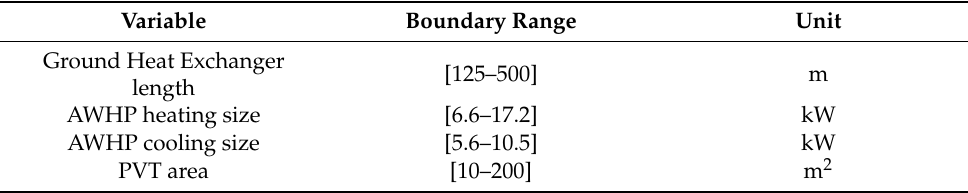
Table 4. Optimization variables and